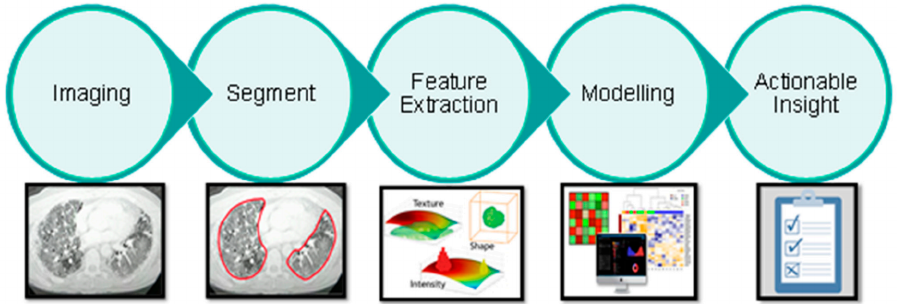
Figure 1. Schematic representation of the radiomics analysis steps: Imaging : chest CT scans of healthy and COVID-19 infected patients were collected and divided between training and testing cohort. Segment : the scans were automatically segmented to delineate the region of interest in the lung. Feature extraction : hand-crafted radiomics feature were extracted from the region of interest. Modelling : the radiomics features were used to train the AI model and the performances were validated in the test set. Actionable insight : the model discrimination performances were assessed in term of accuracy, sensitivity, specificity, negative predictive value (NPV) and positive predictive value